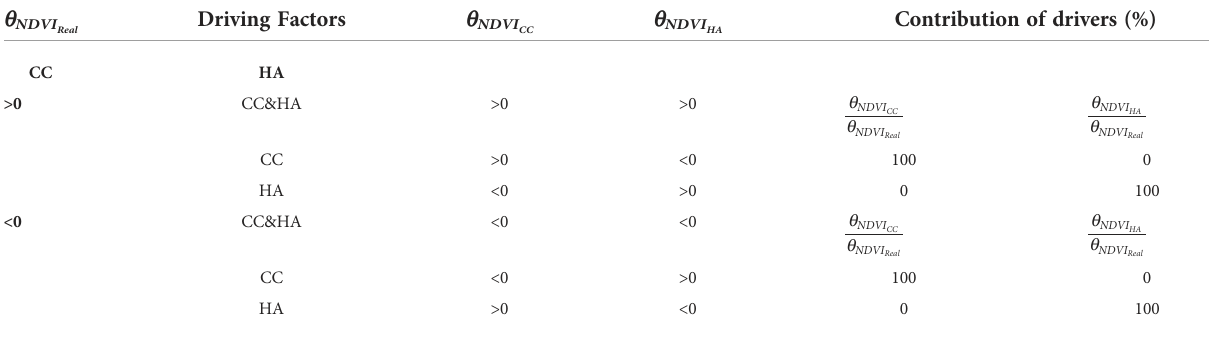
TABLE 2 Determination criteria of driving